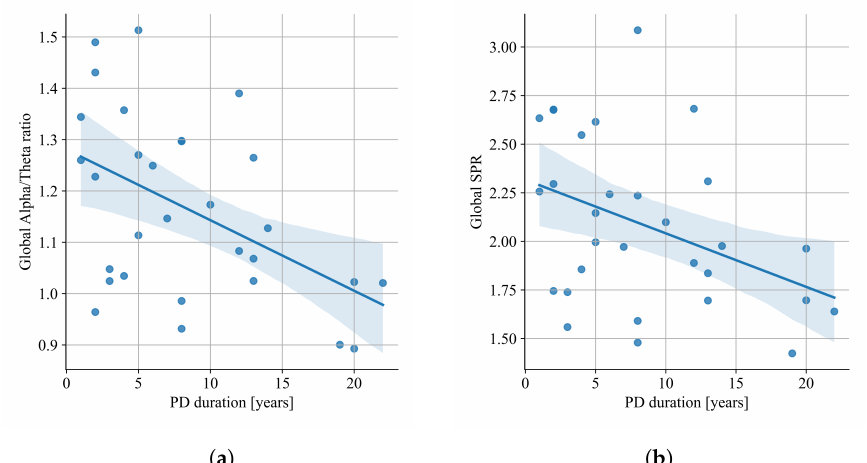
Figure 8. Linear regression of global alpha/theta ratio ( a ) and global SPR ( b ) versus PD duration in PD-MCI group.